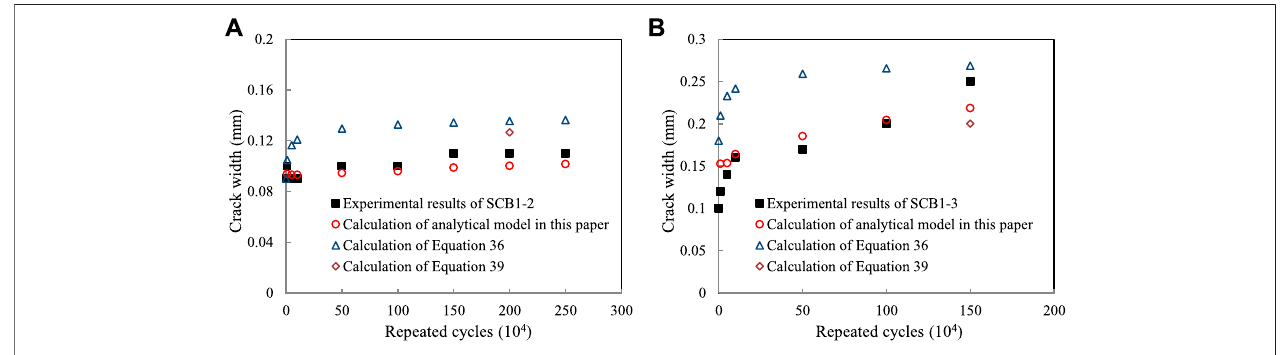
FIGURE 9 | Comparison between calculated and tested values of crack width under fatigue loading: (A) SCB1-2 and (B) SCB1-3.